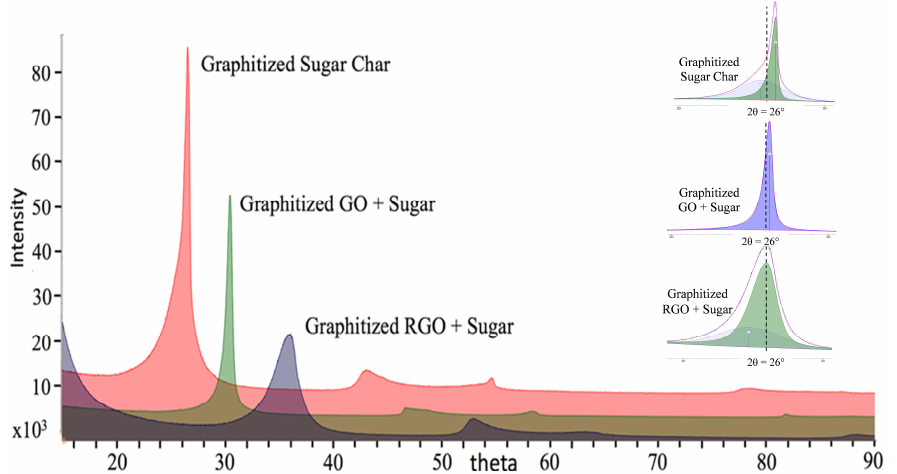
Figure 3. X-ray diffraction spectra for three composites with sugar as matrix precursor, pure and with GO or rGO as additives, illustrating different graphitizing behavior. Note that the X-axis has been shifted to show the three peaks as distinct. However, the peaks occur at 2 θ = 26 ◦ . The inset shows XRD-peak deconvolution for the three materials.